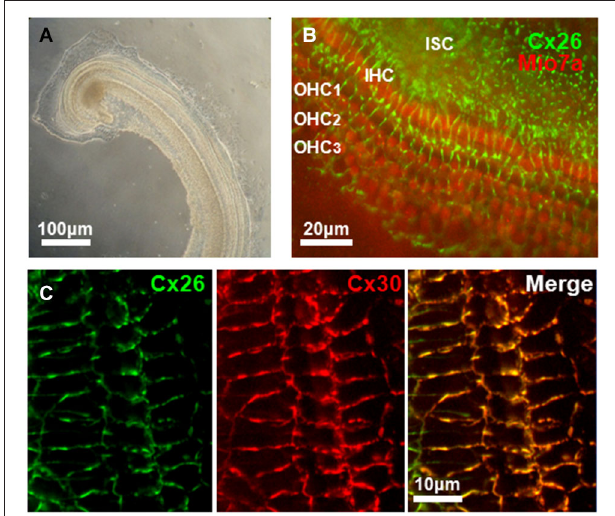
FIGURE 3 | Connexin expression in mouse cochlea. (A) Low-power transmitted-light image of a primary explant culture of cochlea (72 h in vitro ) prepared from a P4 mouse. (B) Immunoreactivity for Cx26 (green), and MyosinVIIa (red), marker of hair cells, obtained from an in vitro primary culture of mouse cochlea after 4 days in culture. Cx26 staining is widespread in cochlea support cells in regions of cell-cell contact. Inner (IHC) and outer (OHC) hair cells are indicated. ISC: Inner support cells. (C) Expression of Cx26 and Cx30 in support cells of organ of Corti in an in vitro primary culture of mouse cochlea after 5 days in culture. Merged image of Cx26 and Cx30 immunostaining shows extensive co-localization of both